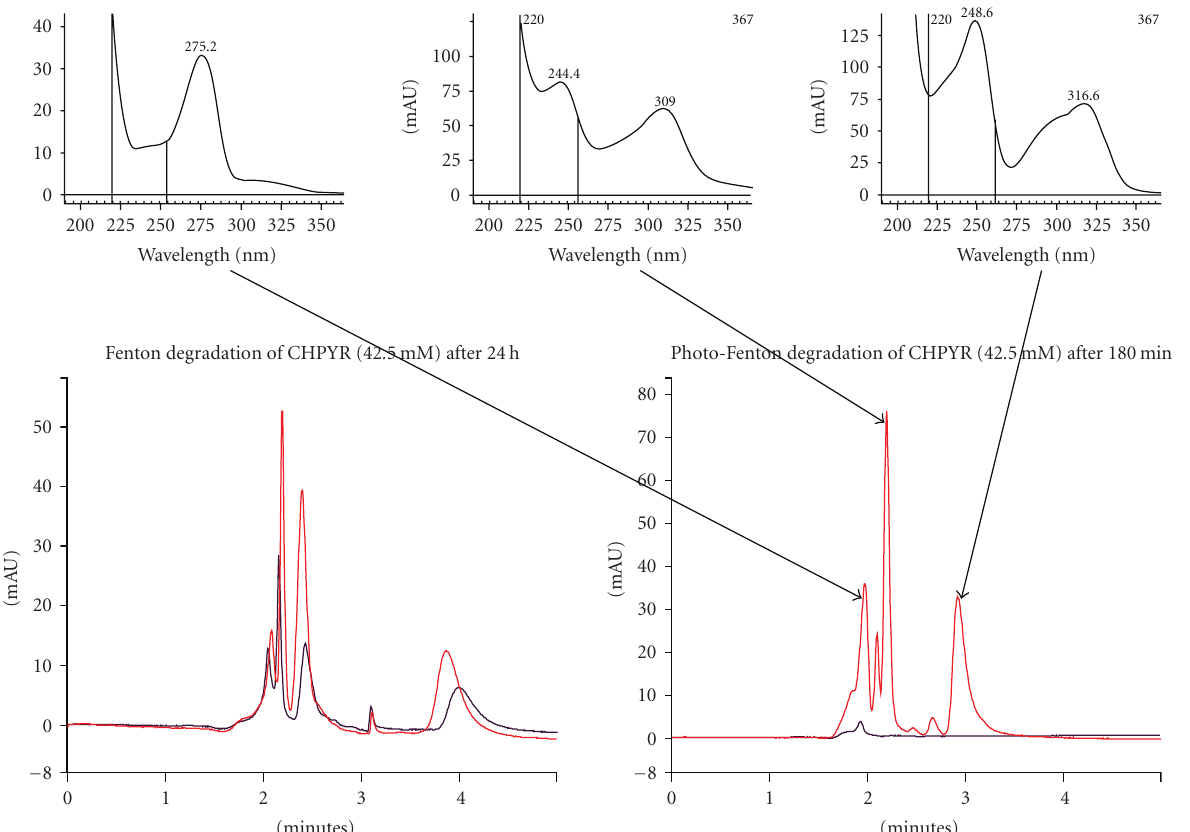
Figure 4: HPLC chromatograms of the CHPYR e ffl uent before and after the Fenton (a) and the photoFenton (b) processes.